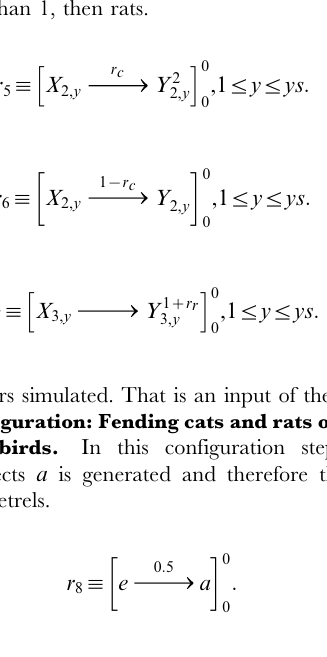
Figure 3. Conceptual representation of the age-structured differential predation model, c i population j where c ~ cats, f ~ fledglings, a ~ adult bird, v ~ vegetation and s ~ skinks. r i is the annual intrinsic growth rate of population i . For birds, a is the adult sex-ratio, b the proportion of breeding adults, d the adult pair fecundity, e the number of clutches, s f the fledgling survival, s j the juvenile survival and s a the adult survival. m is the corresponding mortality where s z m ~ 1 Russell et al. (2009).